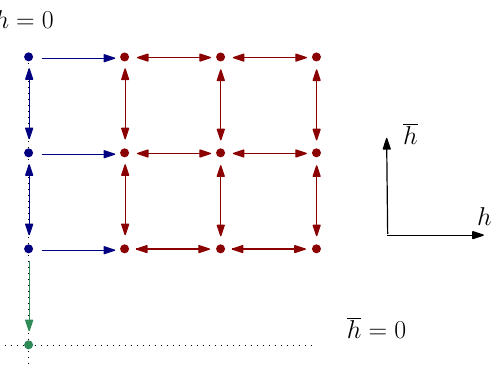
Figure 2 . A diagram showing the smallest SL(2 ; R ) (cid:2) SL(2 ; R ) representation which contains the solutions (2.18). The solutions on the y -axis are t (cid:0) modes, while the solutions in red are t +